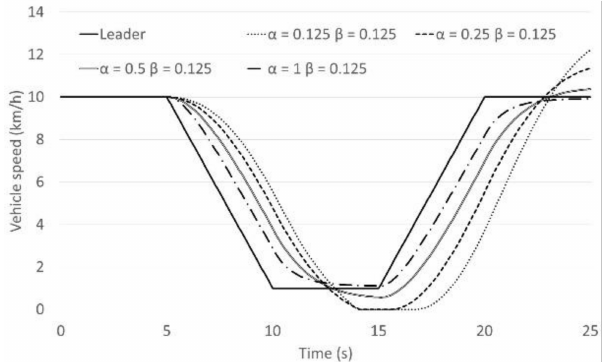
Figure 2. The following vehicle’s speed behaviour ( α is fixed).